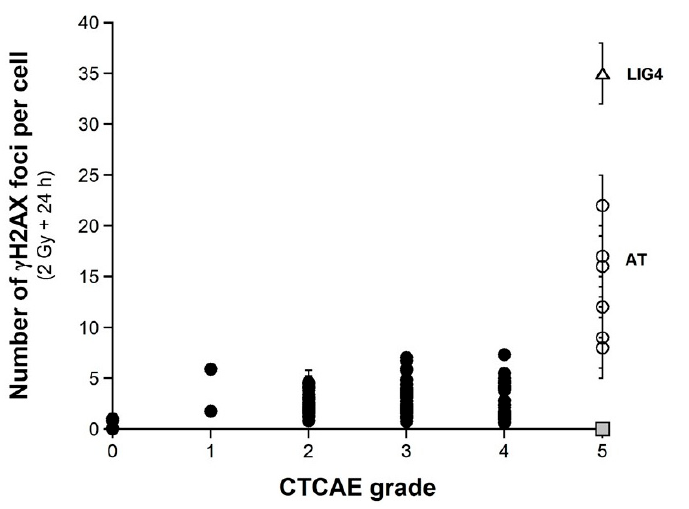
Figure 4. γ H2AX foci vs. CTCAE grades. The number of γ H2AX foci assessed 24 h post-irradiation from 200 COPERNIC cell lines were plotted against the corresponding CTCAE grade values (closed circles). Each point corresponds to the mean ± standard error of the mean (SEM) of three independent triplicates, at least. The points corresponding to the ATM - (open circles) and the LIG4 - (open triangles) mutated cell lines are indicated. The grey square indicates all the AT data if considering γ H2AX foci in ATM -mutated cells as absent.